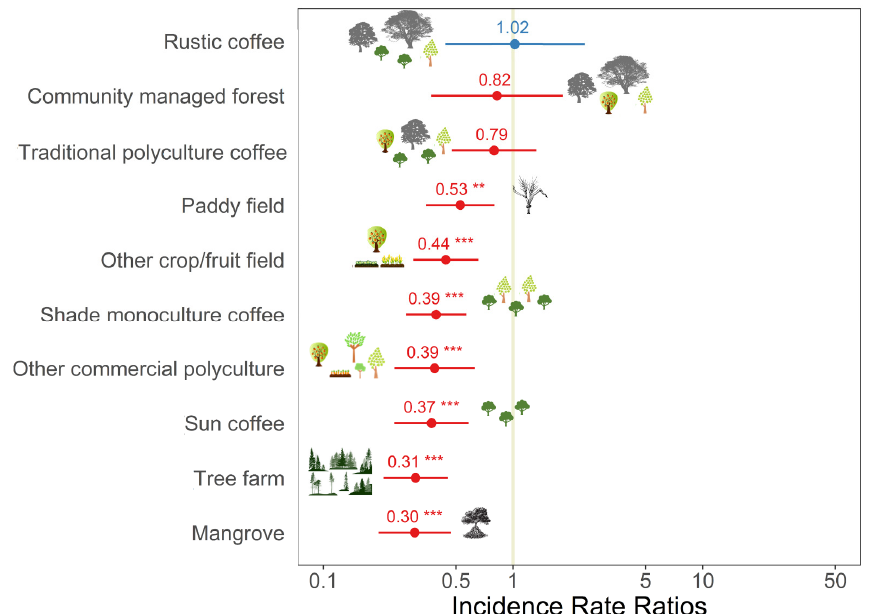
Figure 2. Incidence rate ratios between the abundance of birds in commercial polyculture coffee (reference category) and other habitats considered during the survey on 1228 plots in Java, Indonesia. Data are standardised beta values and 95% confidence intervals from a generalised additive model. A description of the habitats can be found in the methods. Other predictors included in the model can be found in Table 2. ** p < 0.01; *** p < 0.001.